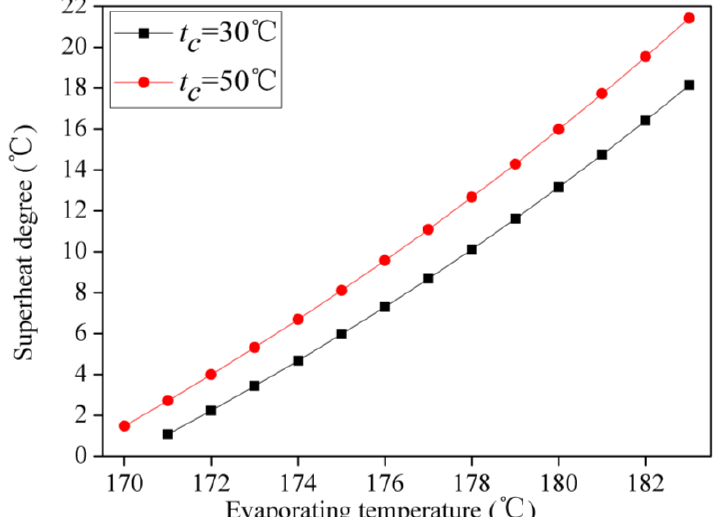
Figure 8. The minimum superheat degree required vs. evaporating temperature